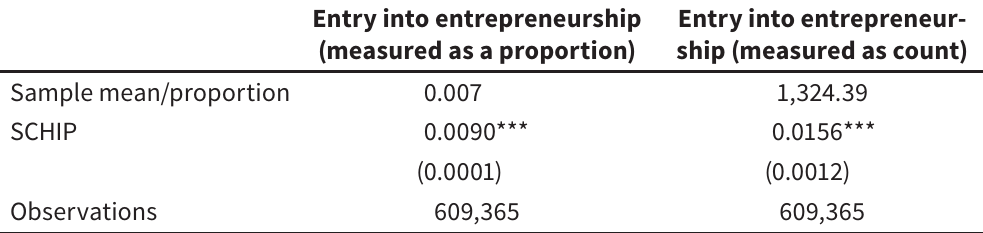
Effect of SCHIP on Entry of Immigrants into Entrepreneurship Entry into entrepreneurship (measured as a proportion)